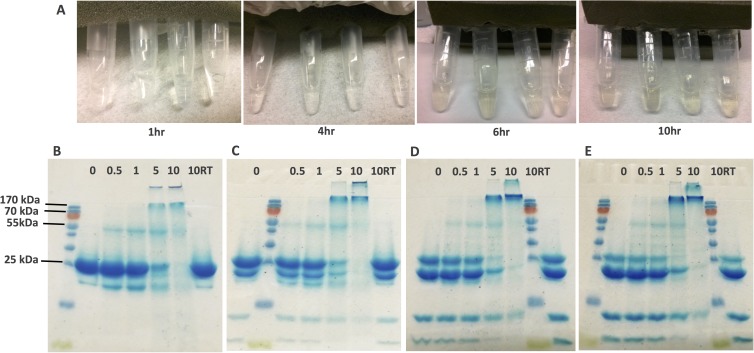
(A) The visual observation of different crystalline protein ratios for α:β:γ as 0:2:1, 1:2:1, 5:2:1 and 10:2:1 (tubes from left to right in both pictures) at different time points of UV-B radiation. SDS-PAGE of (B) 0:2:1, (C) 1:2:1, (D) 5:2:1 and (E) 10:2:1 ratio crystalline proteins. Upper lanes indicate the time points of UV exposure in hours (0, 0.5, 1, 5 and 10) and 10RT indicates 10 hours room temperature incubation (control sample).